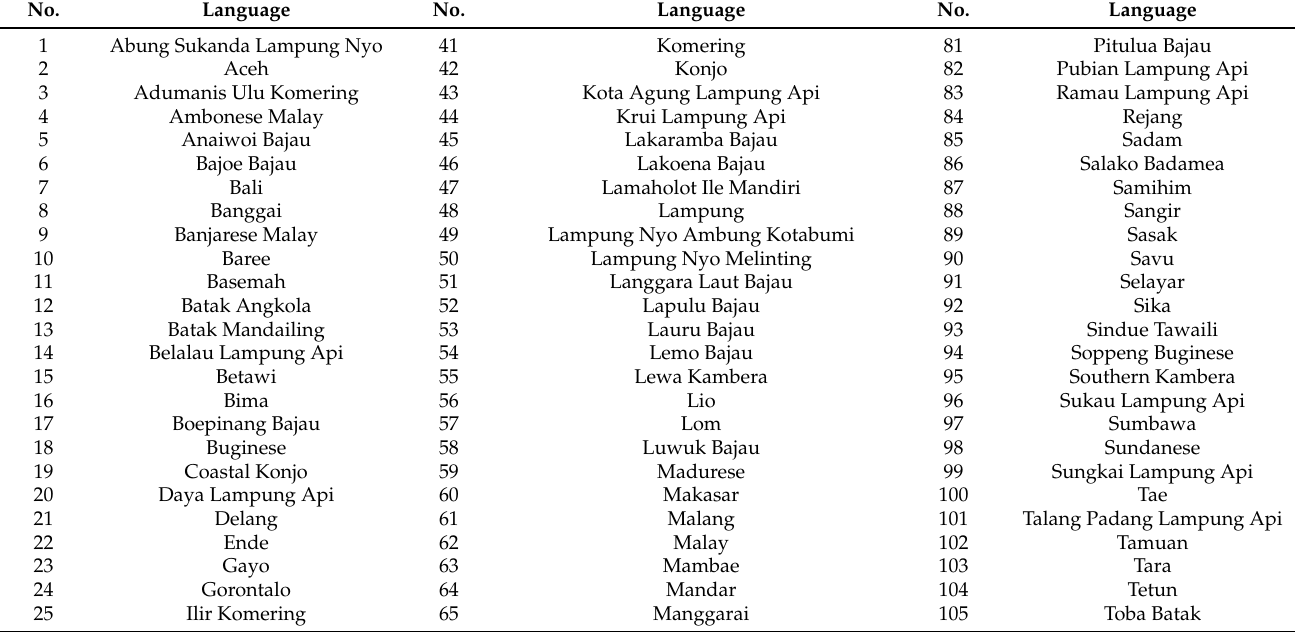
Table 2. Dataset consisting of 119 Indonesian tribal